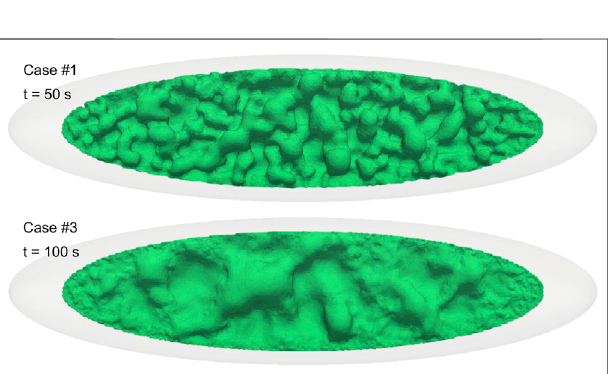
FIGURE 3 | Plume structure looking at the interface from the top. The interface is depicted by isosurfaces of mass fraction Y (cid:2) 0.5.